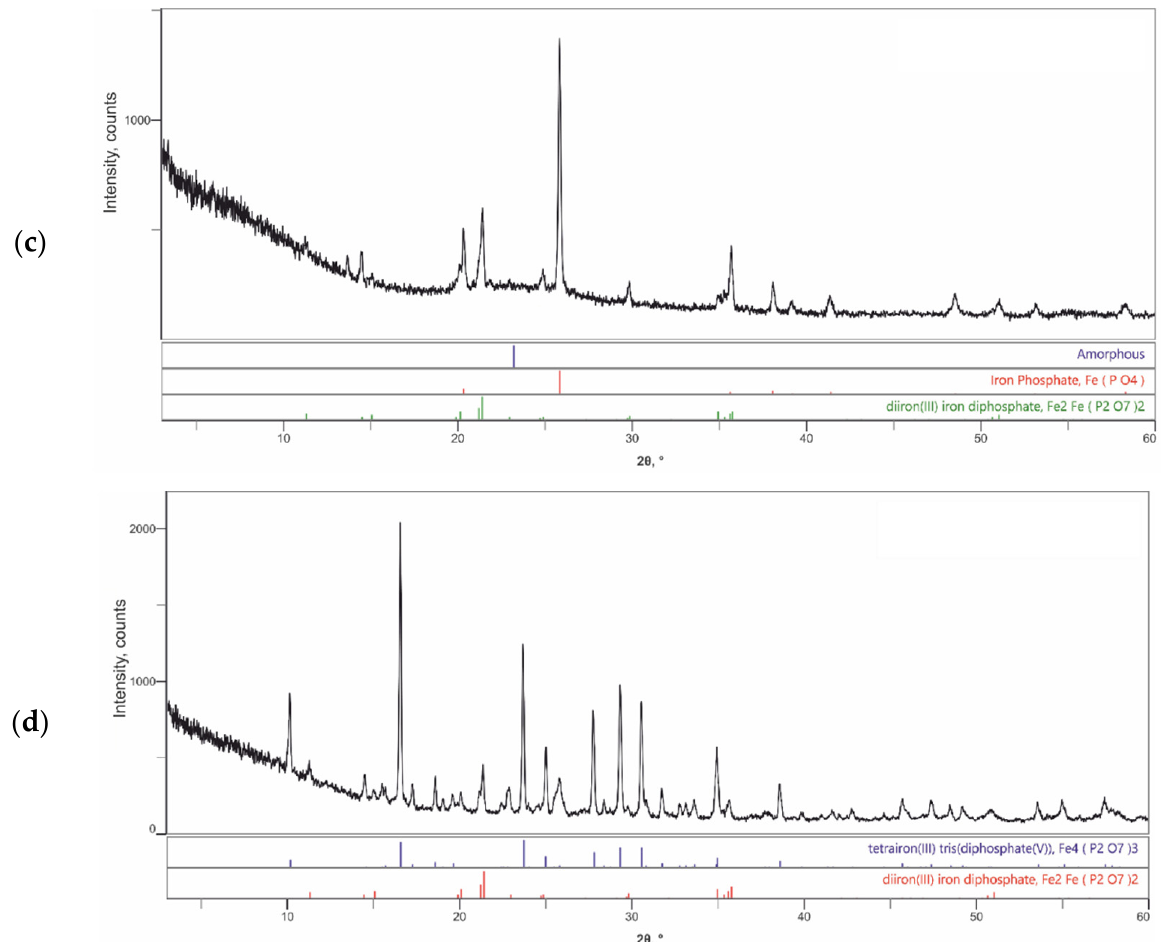
Figure 2. X-ray diffraction patterns of FP matrix samples synthesized at 450 ( a ), 550 ( b ), 650 ( c ) and 750 °C ( d ).